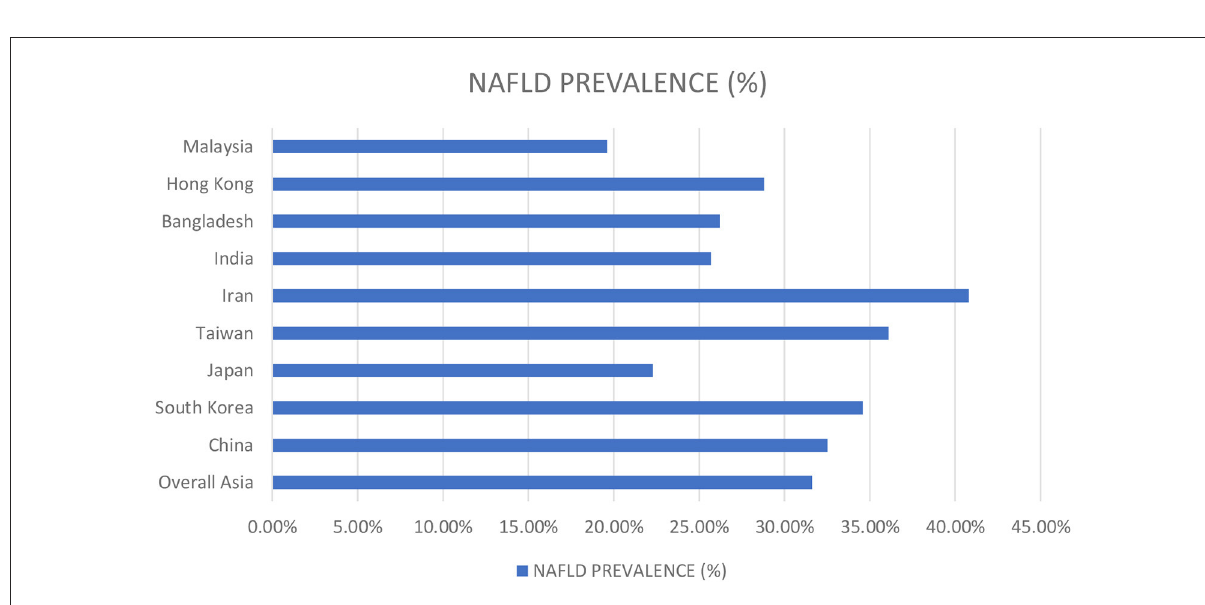
FIGURE3 Demonstrates the prevalence of NAFLD in